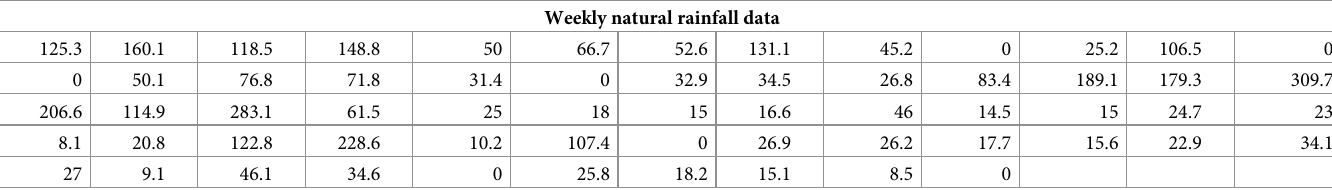
Table 4. Data on weekly natural rainfall in northern Thailand in the week 29 July to 4 August